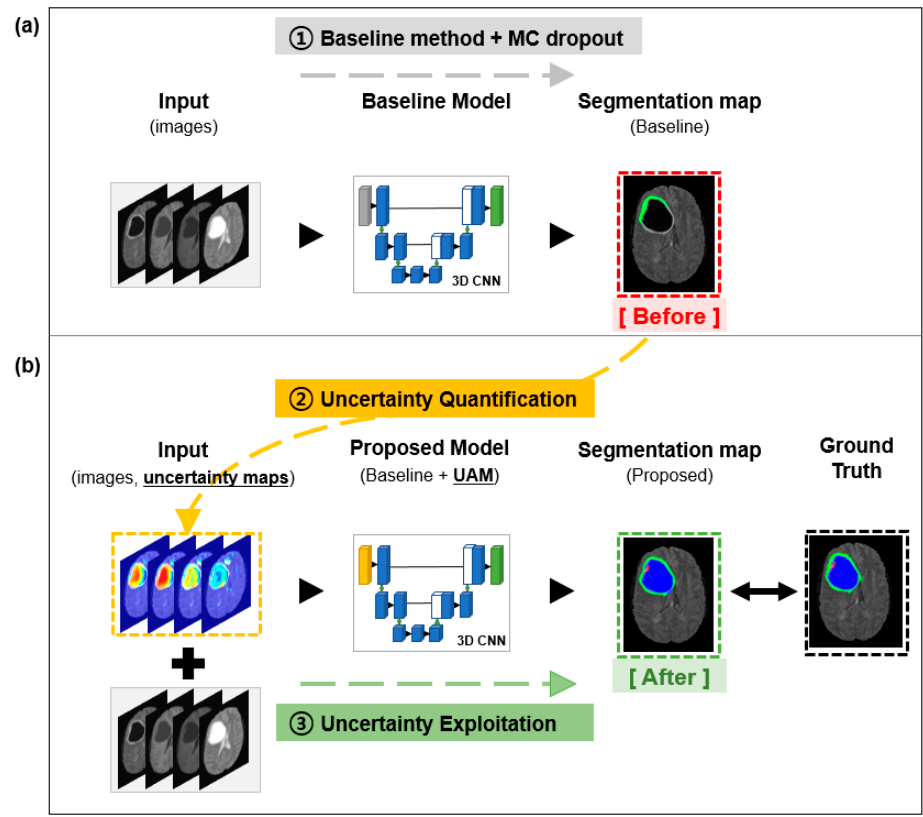
Figure 2. Overview of the proposed framework. ( a ) Feedforward multimodal MRI images into a baseline model with Monte Carlo dropout and generate a baseline segmentation map (Step. 1) ( b ) Quantify uncertainty values of baseline segmentation map by four different measures (Step. 2). Feedforward both images and uncertainty maps into the proposed model and generate proposed segmentation map (Step. 3); MC dropout = Monte Carlo dropout; 3D CNN = 3-dimensional convolutional neural network; UAM = uncertainty attention module.